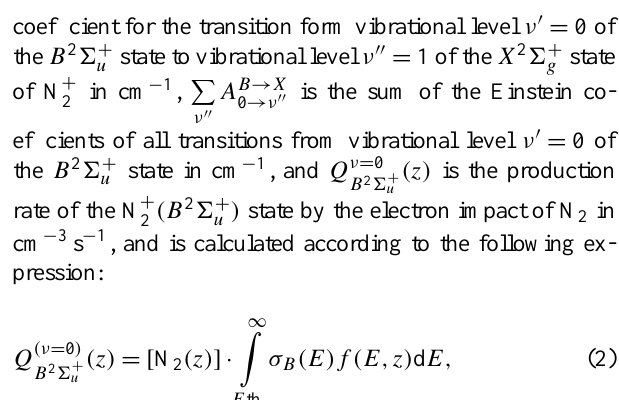
Figure 3. Intensity of the arc measured by ALIS and MAC before removing the background intensity. The dashed lines show the back- ground intensity that is later removed from each intensity measure- ment.